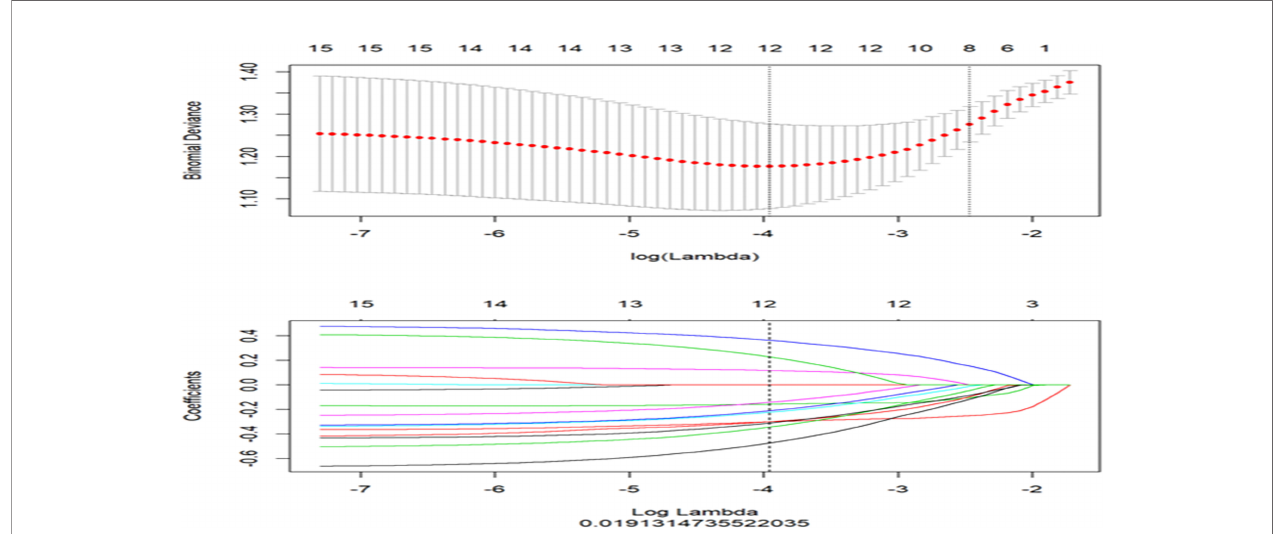
FIGURE 2 | The least absolute shrinkage and selection operator (LASSO) regression for radiomics features selection and signature construction. The top graph represents in LASSO model, with the penalization parameter l selection using 10-fold cross-validation as the minimum criteria. The log ( l ) (x-axis) was plotted against the partial likelihood of deviance (y-axis). Dotted vertical lines were drawn at the minimum criteria and the 1 − SE criteria. l value of 0.019, with log ( l ), − 3.96 was chosen (1 − SE criteria). The bottom graph represents LASSO coef fi cient pro fi les of the radiomics features. Ten-fold cross-validation in the log ( l ) sequence was used to draw the vertical line at the value selected; also indicated are 12 features with non-zero coef fi